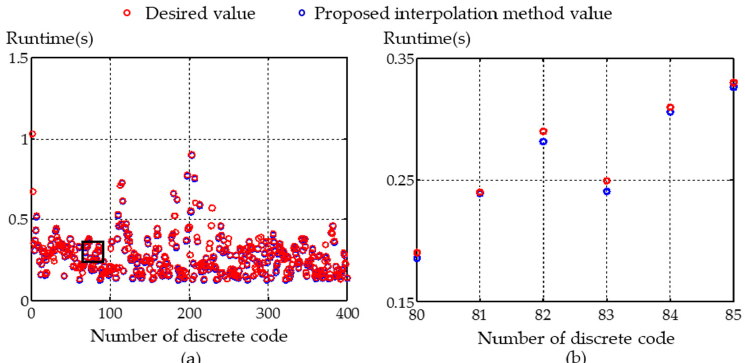
Figure 6. Runtime of the trajectory interpolated by the proposed method: ( a ) runtime of the trajectory; and ( b ) the partial enlarged view.